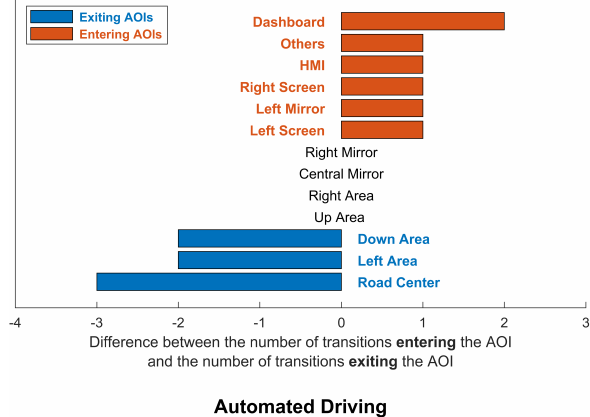
Figure 6: Visualisation of exiting AOIs (blue) and entering AOIs (orange) for automated